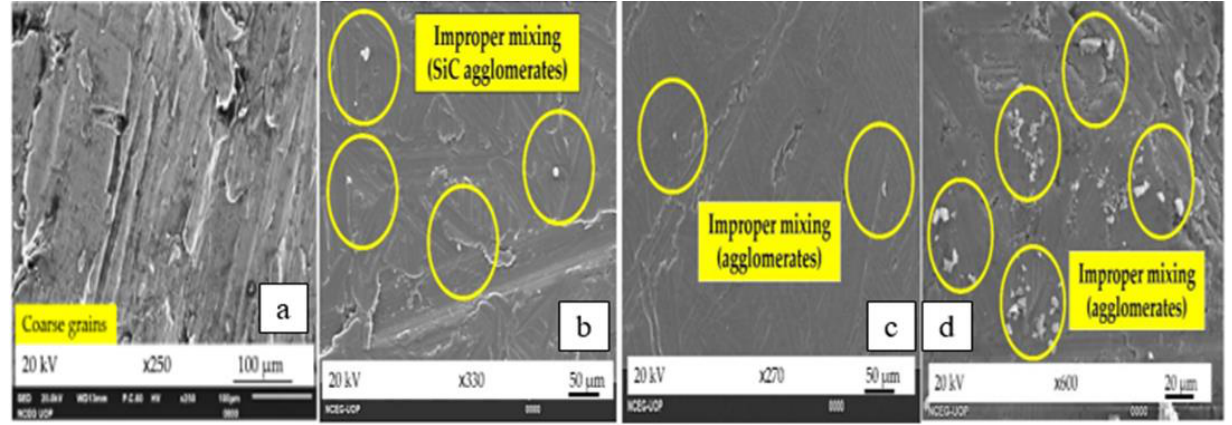
Figure 12. SEM image’s microstructural study of: ( a ) AA7075 alloy, ( b ) AA7075–5wt%SiC, ( c ) AA7075–5wt%SiC–3wt%RHA, and ( d ) AA7075, 5 wt% SiC, 3 wt% RHA, 1 wt% CES.